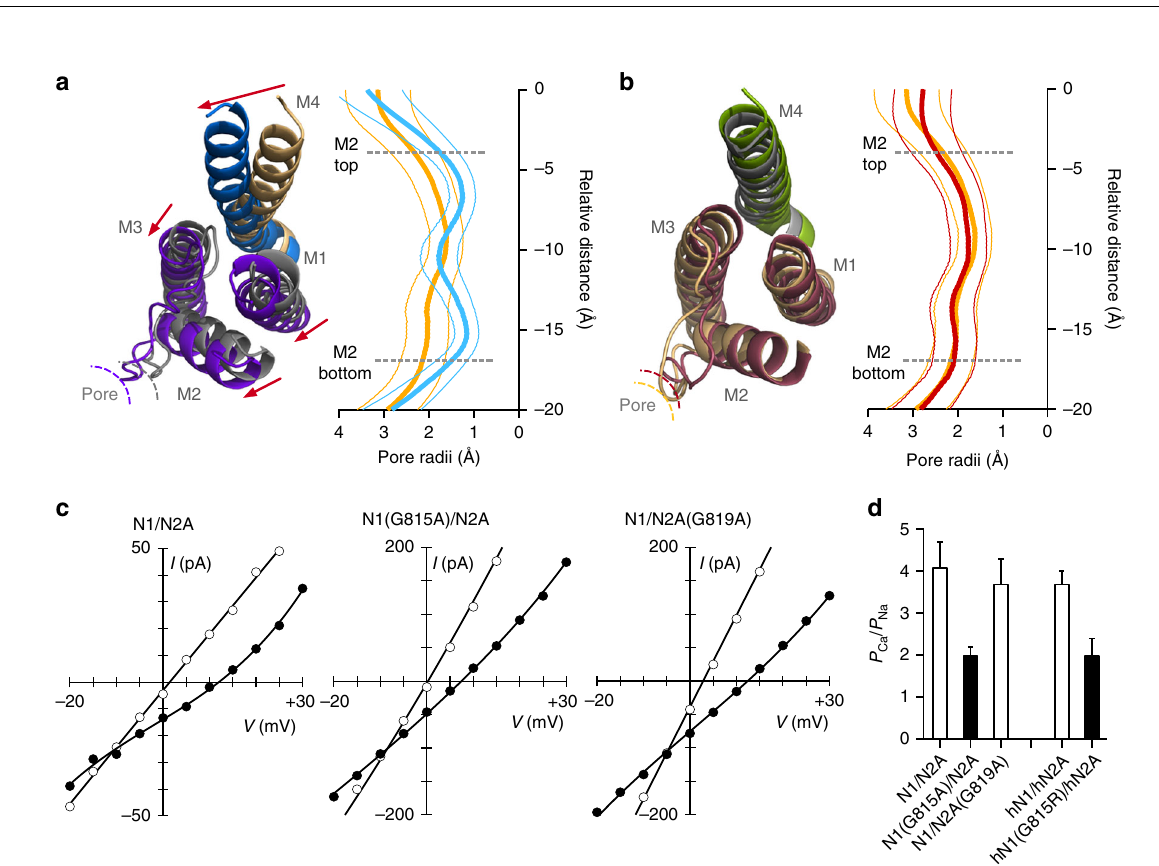
Fig. 8 Constraining the conserved G in GluN1 reduces the dimensions of the selectivity fi lter and Ca 2 + permeability. a Left, Cytoplasmic view of model open state structures of wild type and GluN1(G815A). The constrained M4 collapses the adjacent GluN2B ion channel core (M1 – M3) including the pore size as de fi ned by the M2 loop. Right, Average pore radius along the channel axis for the M2 pore loop for wild type (gold) and GluN1(G815A) (light blue). ’ 0 ’ references the serine (S) in SYTANLAAF in M3. Thick lines are mean values and thinner lines the error bars, which were calculated using block averages based on a time block of 20 ns. b Same as a except construct is GluN2B(G820A) (maroon), which resulted in a less displacement of the M2 loop. c Current-voltage (IV) relationships in an external solution containing high Na + (140 mM) and 0 added Ca 2 + (open circles) or 10 mM Ca 2 + (solid circles). The 0 Ca 2 + IV is the average of that recorded before and after the 10 mM Ca 2 + recording. We used changes in reversal potentials ( Δ E rev ) to calculate P P P Δ E n = 7), GluN1(G815A) ( n = 8), or 37 . d Mean ± SEM showing relative calcium permeability ( P Ca / Na Ca / Na ) calculated from rev s for rat GluN1/GluN2A ( GluN2A(G819A) ( n = 7) as well as human GluN1/GluN2A ( n = 11) and the missense mutation GluN1(G815R) ( n = 7). Values either are not (open bars) or are (solids bars) signi fi cantly different from each other ( p < 0.05, ANOVA,